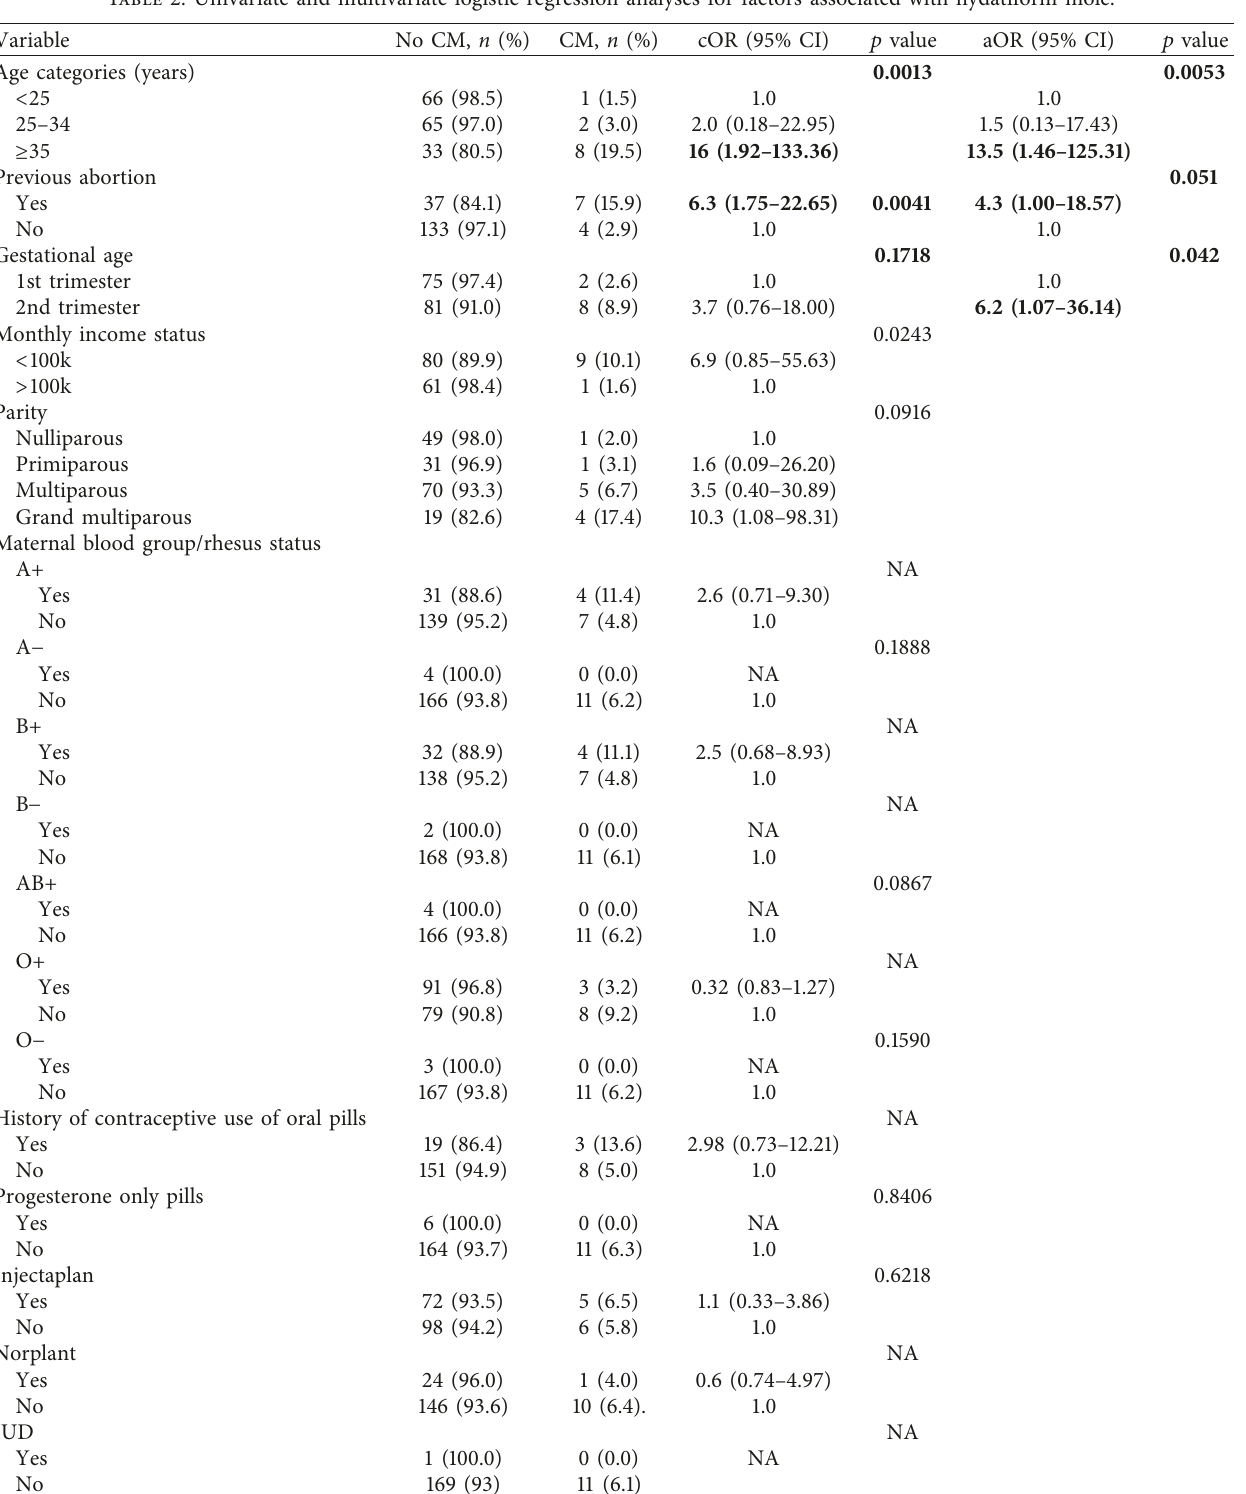
Table 2: Univariate and multivariate logistic regression analyses for factors associated with hydatiform